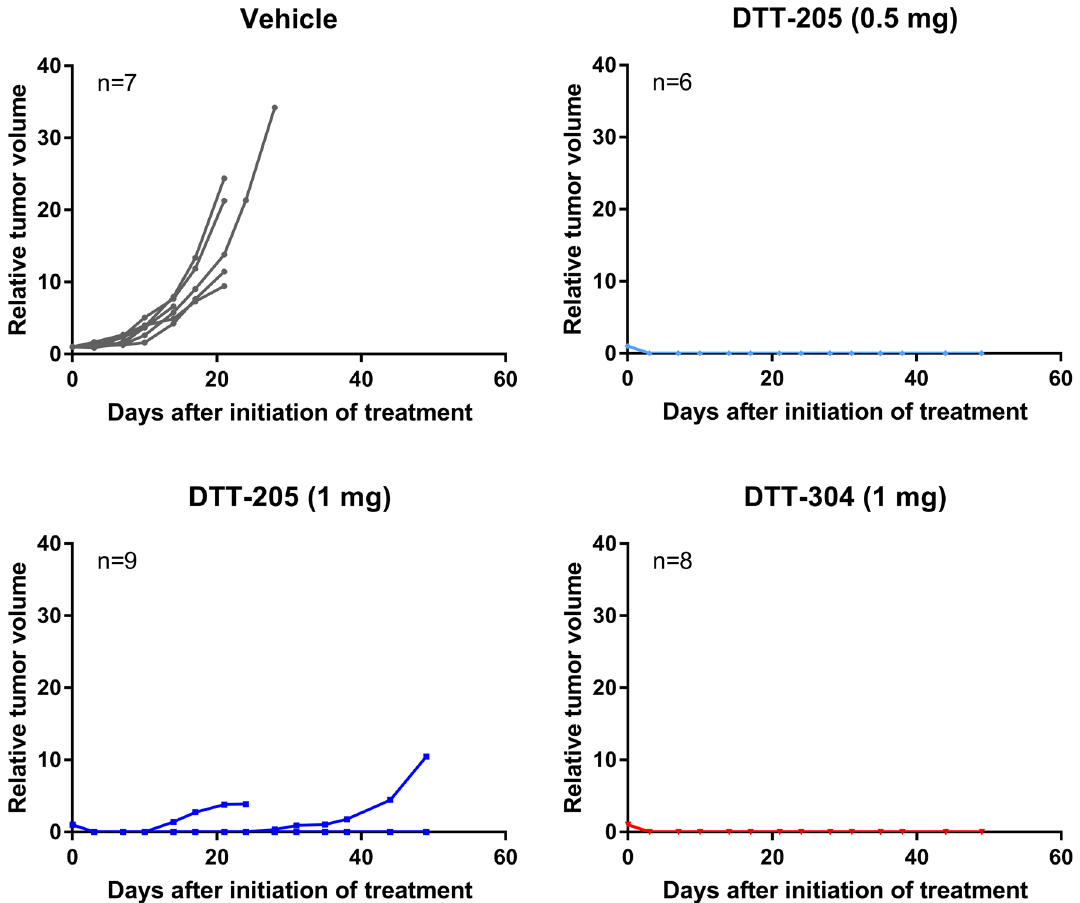
Figure 2. Response to DTT-205 or DTT-304 treatment in MC38 tumors. Tumor growth curves of MC38 tumors treated with saline, 0.5 mg DTT-205, 1 mg DTT-205 or 1 mg DTT-304. Mice were treated for three consecutive